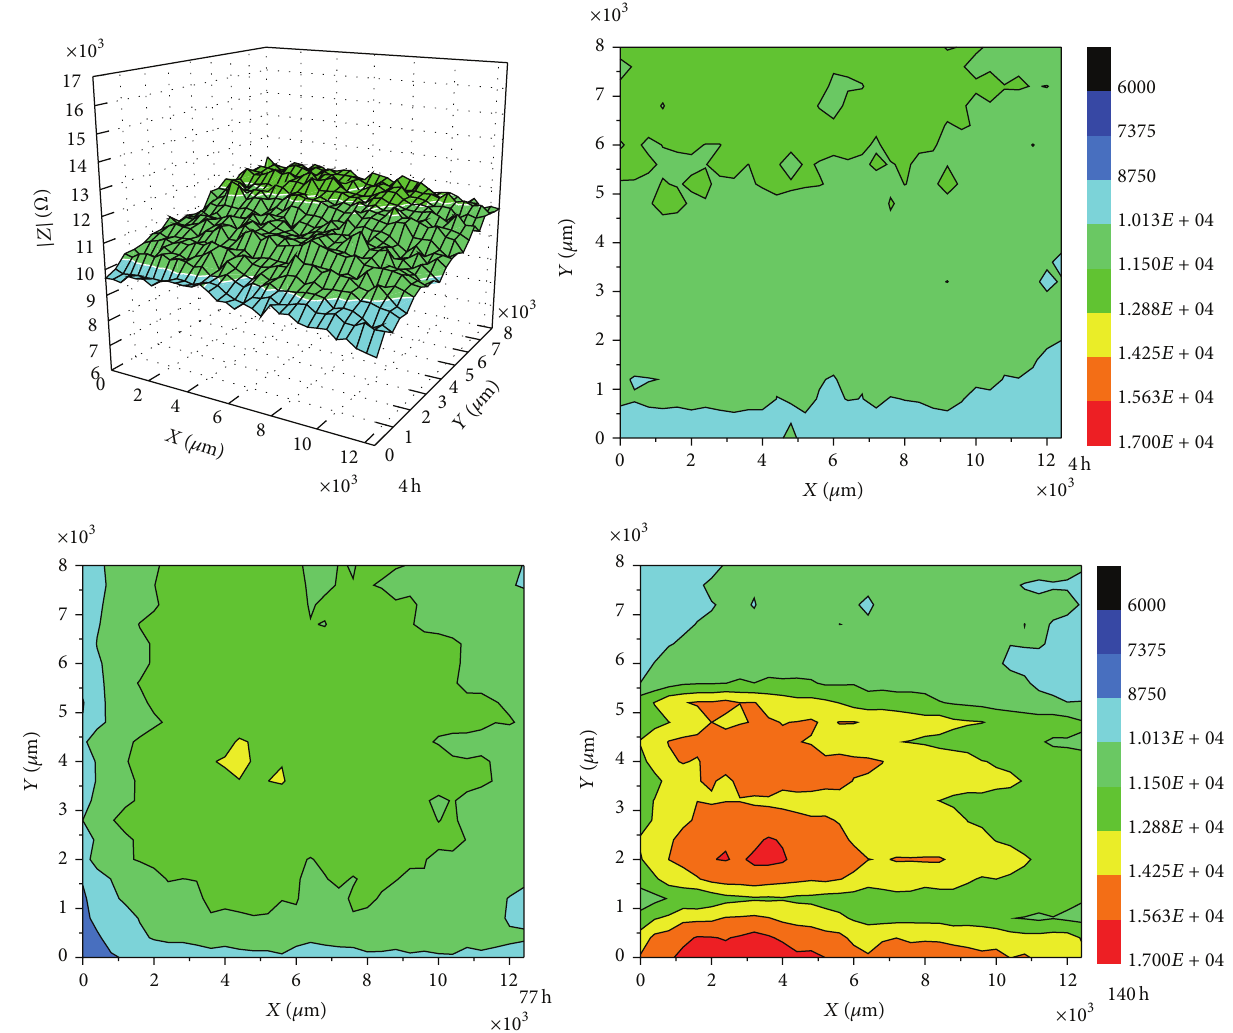
Figure 10: Time dependence of LEIS profiles and their projections of studied painted samples.